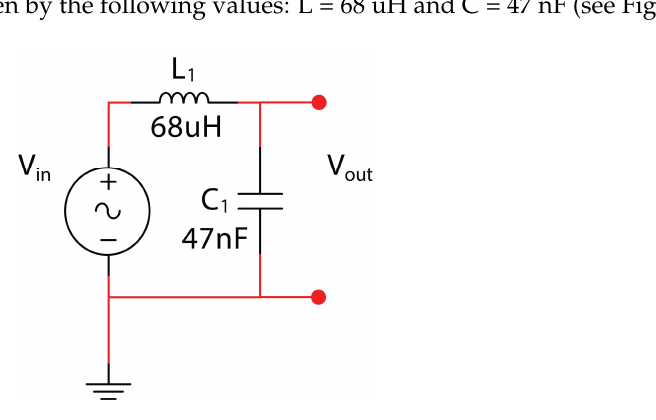
Figure 4. Single L–C cell used as a ‘standard’ for the reference condition of the L.N. in this work.